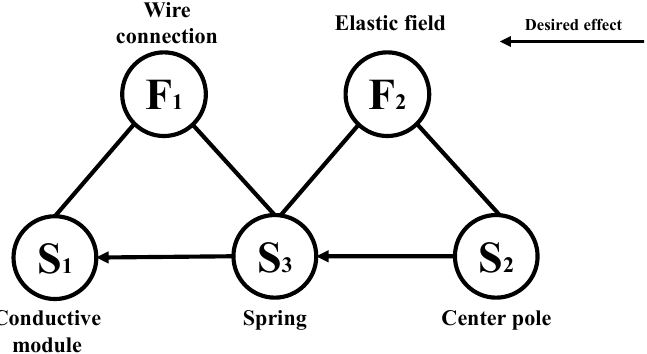
Figure 13. Improved object–field model of the conductive module. By adding a spring mechanism between the center pole and the conductive module, and introducing an elastic force field, the problem of insufficient or excessive contact between the conductive modules is solved. center pole can be obtained, as shown in Figure 14 [41].